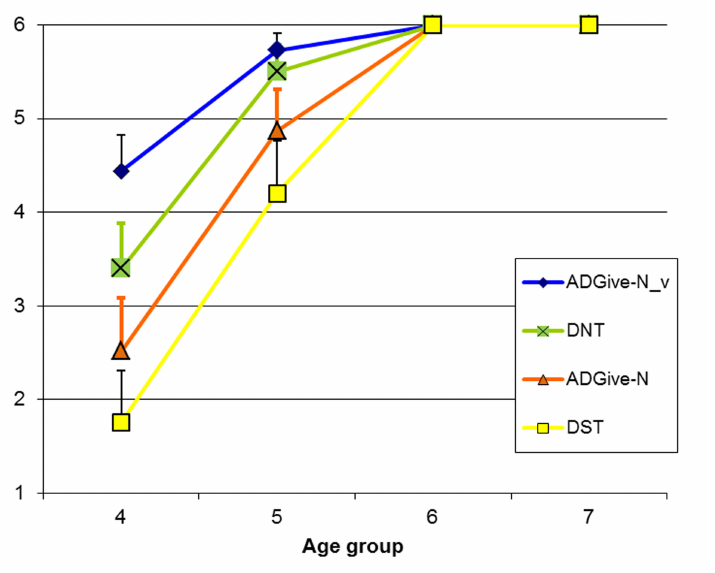
Figure 4. Mean number of Arabic digits (DNT: number words correctly assigned to the digits; DST: amount of digits laid out in a correct order; ADGive-N: correct cardinal values produced for digits) and number words (ADGive-N_v: correct cardinal values produced for number words) across tasks as a function of age. Error bars represent standard errors of the means.